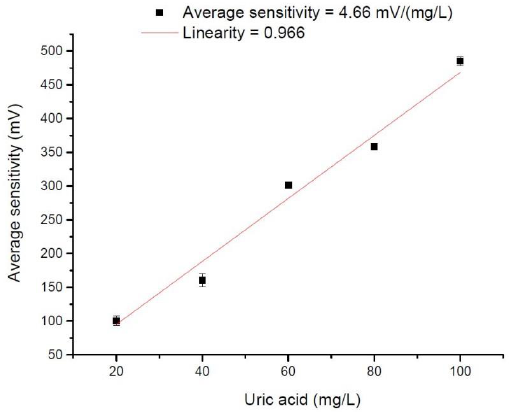
Figure 11. AgNW – uricase/rGO/NiO uric acid biosensor under an uric acid concentration range of 20 – 100 mg/L.